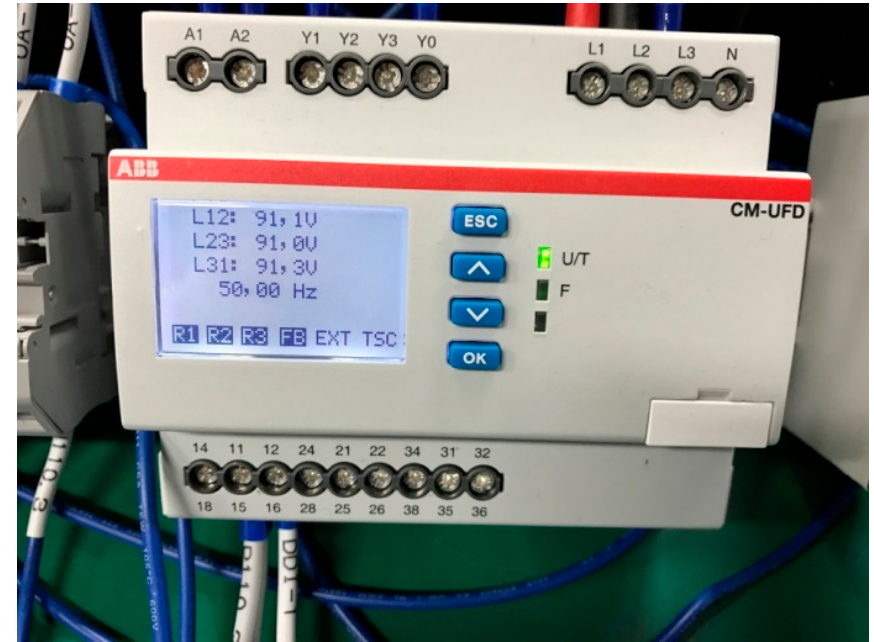
Figure 29. Resetting under voltage relay.